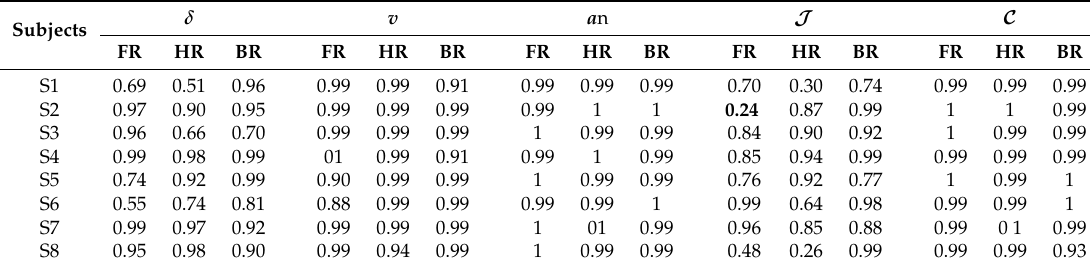
Table 3. Anderson–Darling test p-value for all riding instructions and